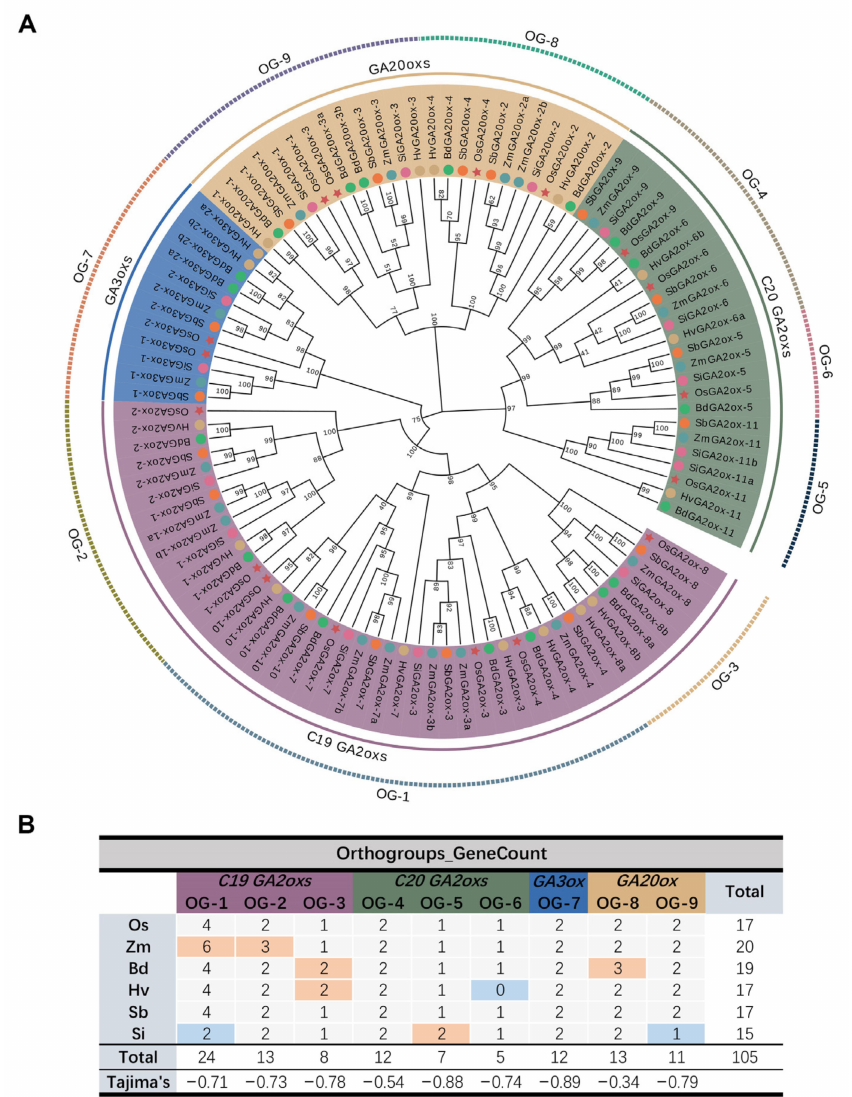
Figure 1. Identification and orthologous analysis of GAox genes. ( A ) A phylogenetic tree constructed by 105 protein MSA files. GAox genes of six species are labeled by various colors. The four colored backgrounds (purple, blue, yellow, and green) represent four subfamilies. Nine OGs are annotated by dotted lines with different colors. ( B ) Statistical analysis of orthologous genes among six plants and Tajima’s D-values of nine OGs. Orange and blue backgrounds represent expanded or lost species compared to rice in the same OG group,